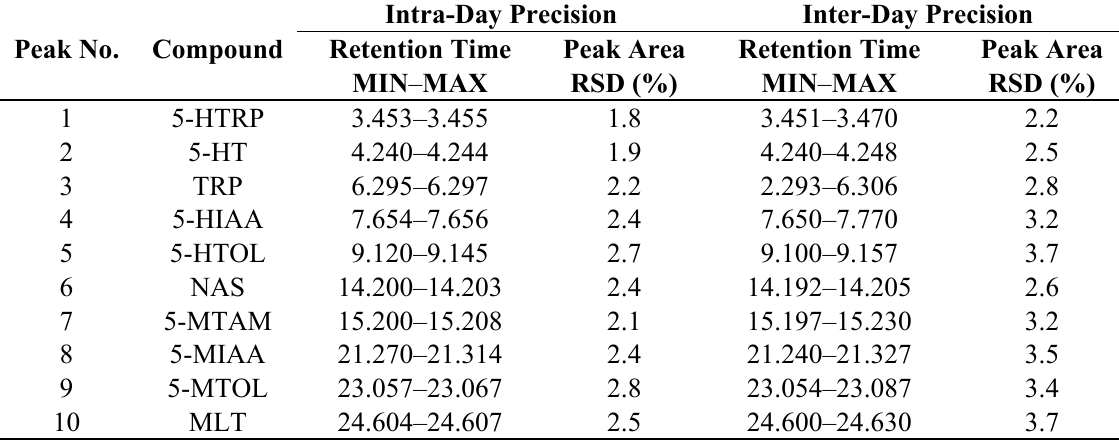
Table 1. Intra-day and inter-day precision of the indole assay using HPLC with fluorescence detection. The standard solution containing 25 ng of each compound in 1 mL of 0.1 M perchloric acid was divided into aliquots and stored at −80 °C. After thawing, 10 µL of the solution was injected with ten replicates on the same day or once a day during ten consecutive days. The retention times and the peak areas were determined using Chromeleon 6.8 software (Dionex, Sunnyvale, CA, USA). Peak No.